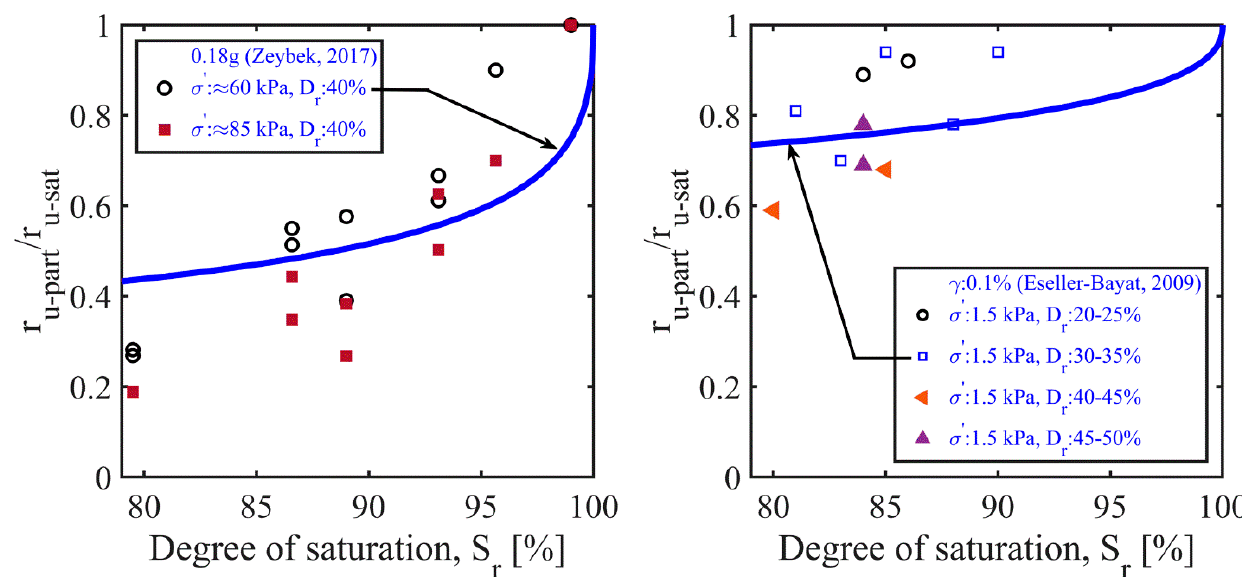
Figure 17. Validation of the predictions against centrifuge [65] and 1 g shaking table [66] test data.